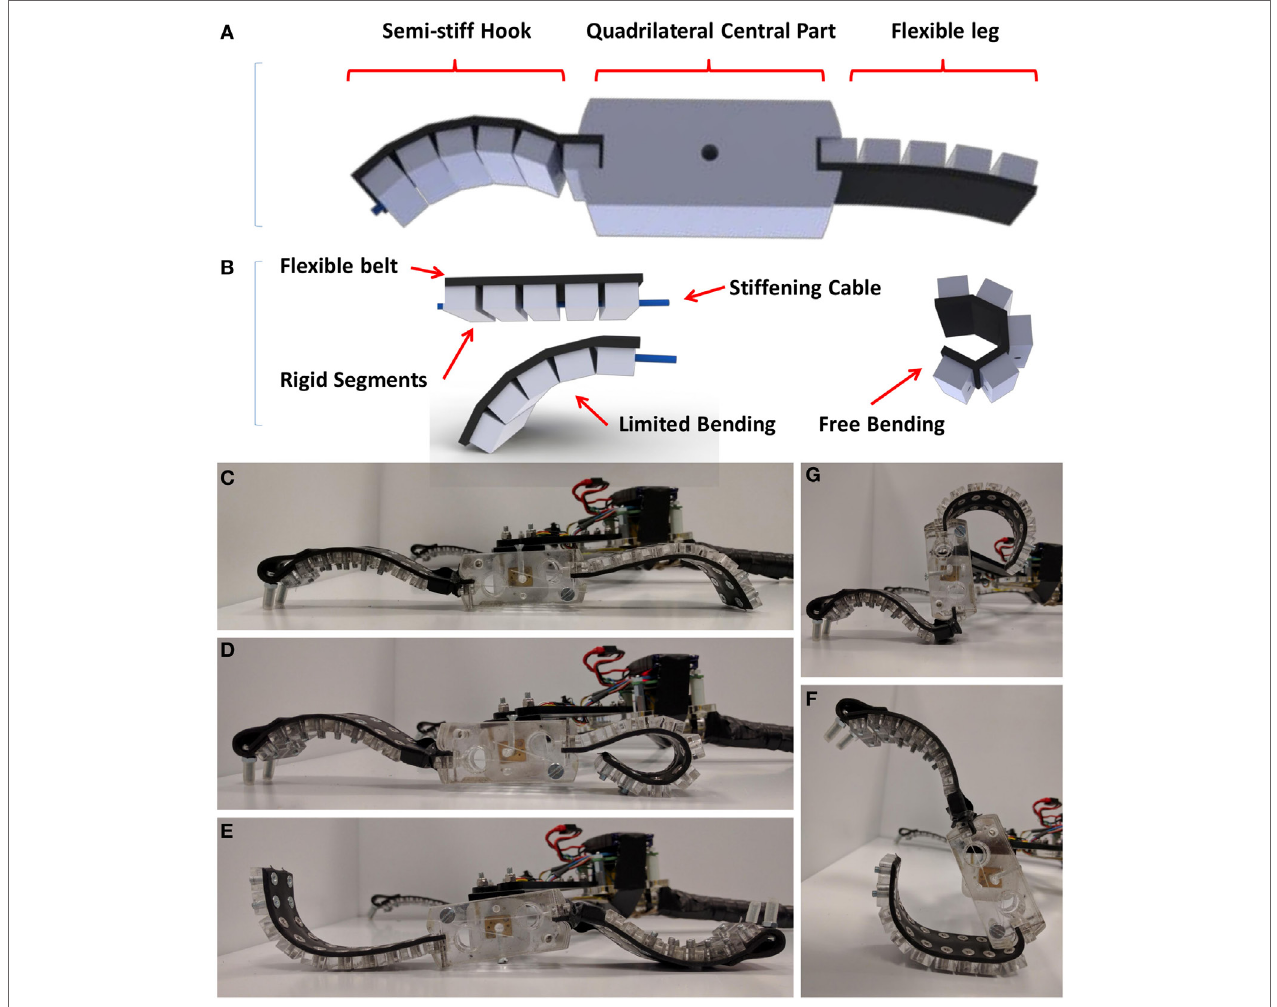
FigUre 3 | (a) CAD model of the wheel with two legs in the sides. (B) CAD model of flexible legs made of a flexible belt and rigid segments; the bending of belt is limited by the rigid segments from one side. From the other side, it can bend freely or its bending can be controlled by means of a cable. (c) Normal position of fabricated wheel on the ground. (D) The soft leg can bend with any radius. (e) The soft leg advances than wheel can touch the ground. (F) Wheel can role on the soft leg independently to the ground properties. (g) The bending of semi-stiff leg is limited and can function as a hook for climbing over